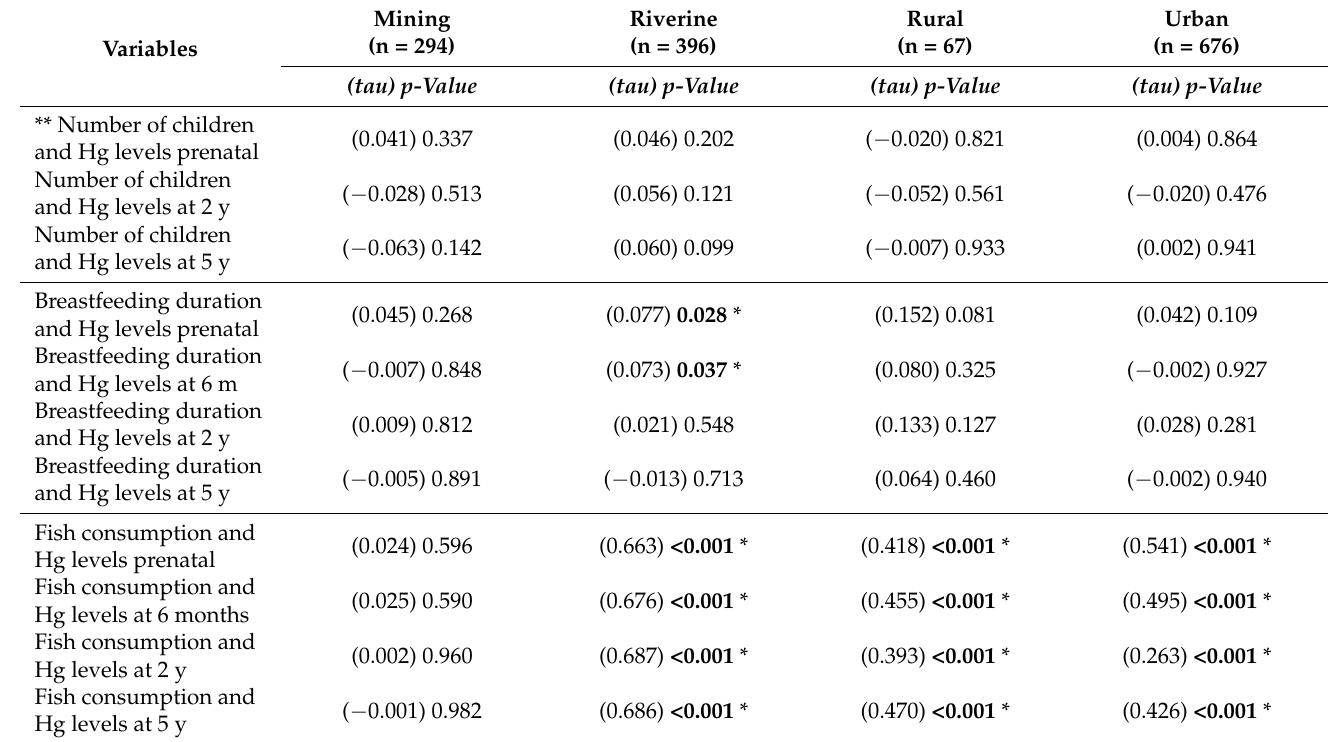
Table 4. Correlation between Total Hg levels (in µ g · g − 1 ) and number of children, breastfeeding duration and fish consumption in the prenatal period, after 6 months, 2 and 5 years of studied women (n = 1433), according to the place of residence, Rond ô nia State, Brazilian Amazon.